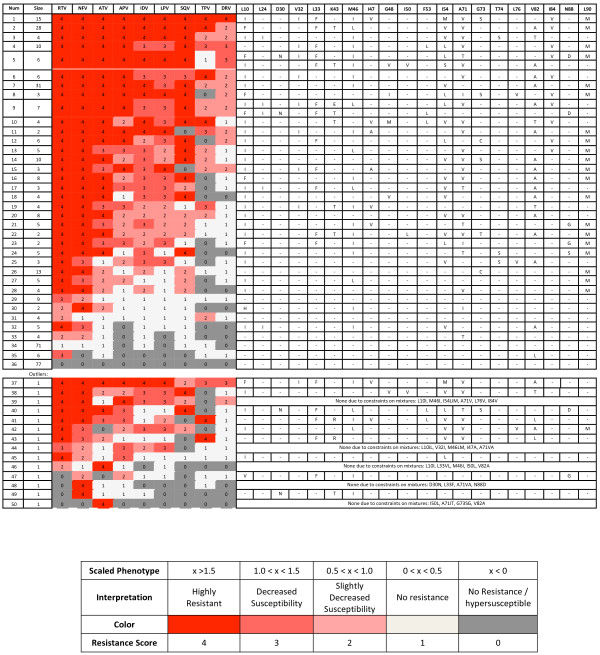
Optimal phenotypic clustering of clinical data set. The optimal set of clusters obtained by using constrained k-medoids clustering with integer programming. 36 multi-membered clusters and 14 single-member "clusters", or outliers, were obtained. Each row represents one cluster. The second column indicates the cluster size. The next 9 columns represent the cluster centroids' phenotypic drug resistance scores, colored according to the legend. The columns at right indicate mutations in the sequence selected to represent the cluster at selected positions. Because isolates with mixtures at any of the specified positions were not allowed to represent a cluster, certain single-membered clusters do not have a representative "sequence." The representative sequences chosen for clusters 29, 31, 34, and 36 show no mutations at the positions listed here, but they have substitutions at other positions (Table S1, Additional File 1).